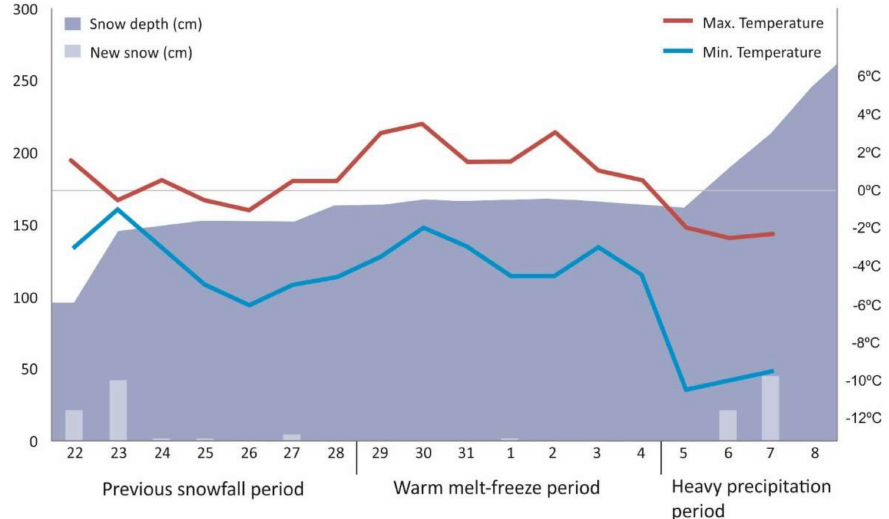
Figure 5. Snow depth (cm), new snow (cm) and minimum and maximum daily temperatures from 22nd January to 7th February 1996, observed at the manual weather station at the Arinsal ski resort (1927 m